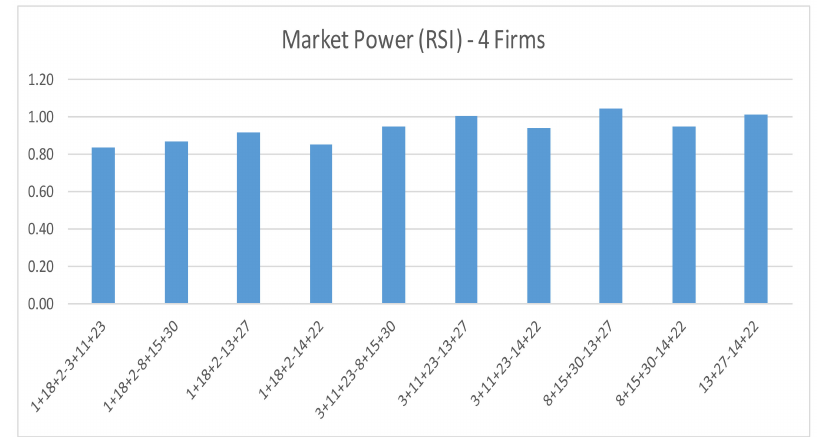
Figure 13. RSI for 4 firms’ setting (PC).